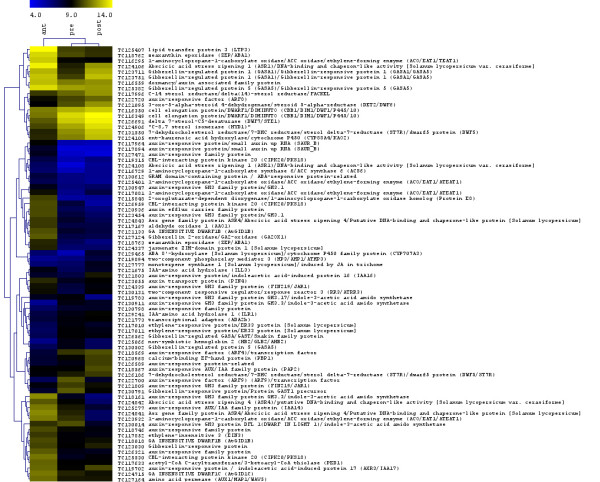
Hierarchical clustering of expression for the differentially expressed genes involved in plant hormone biosynthesis and signaling. Differentially expressed genes related to hormone were selected by multtest package in R. Shown are heat map representations for averaged expression intensities. All data are presented as log2 (RMA expression value).